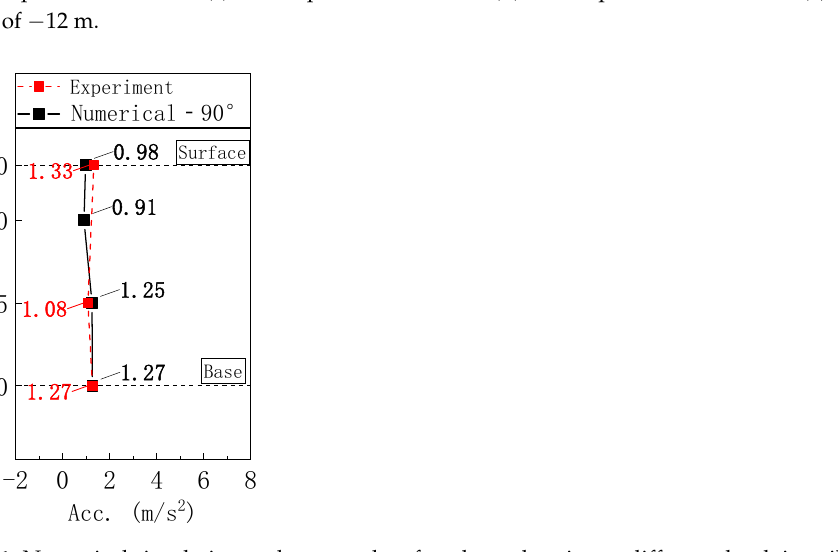
Figure 11. Numerical simulation and test results of peak acceleration at different depth in soil.